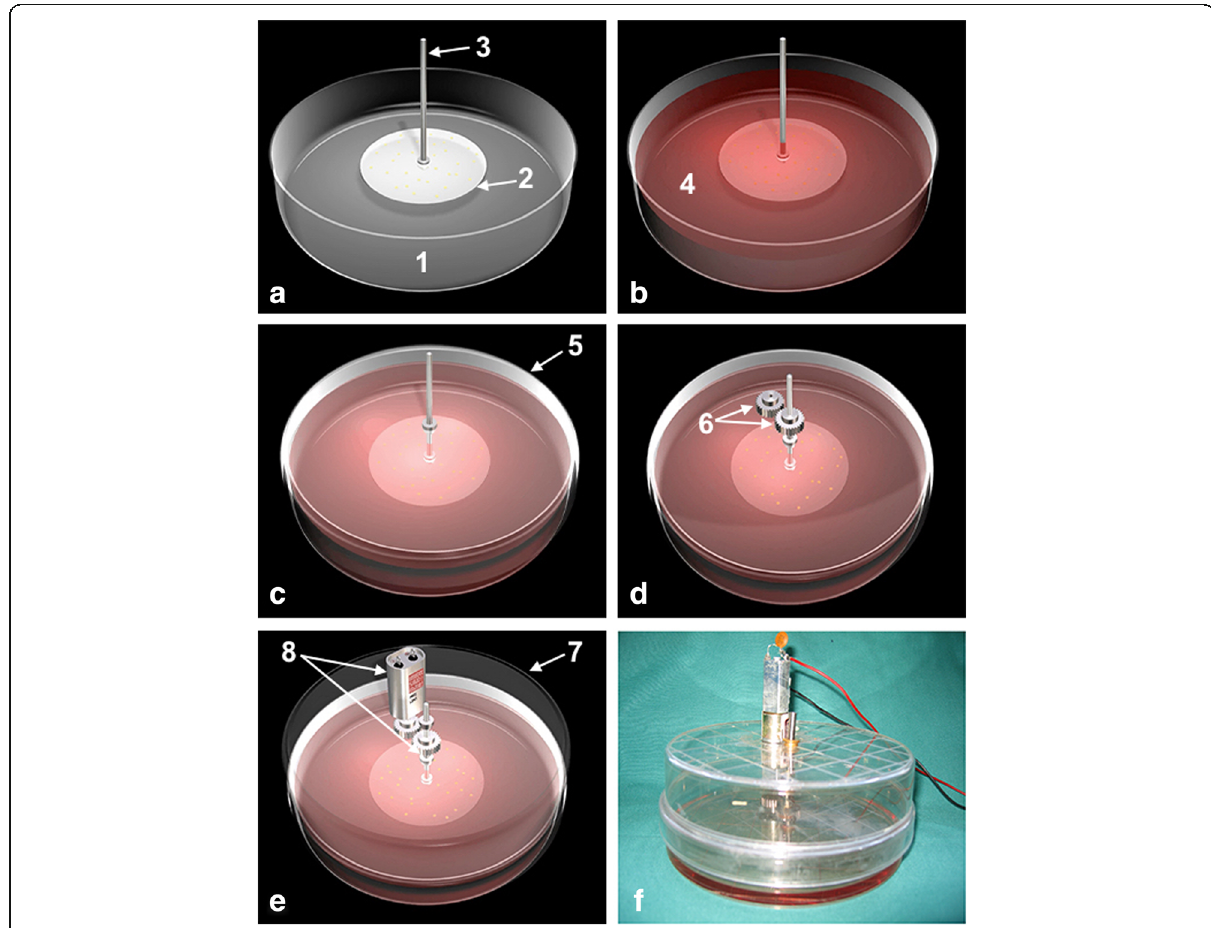
Fig. 1 Three-dimensional illustration ( a – e ) and photography ( f ) of the experimental setup with the components marked numerical. a 1 Lower petri dish (s ’ bottom serving as the lower plate); 2 Rotating glass panel [60 mm diameter (cell bearing)]; 3 Titanium axis. b 4 Liquid medium ( red ). c 5 Reversed upper petri dish. d 6 Gearwheel with set screw. e 7 Closing; 8 Electronic motor device and adjusting ring with additional set